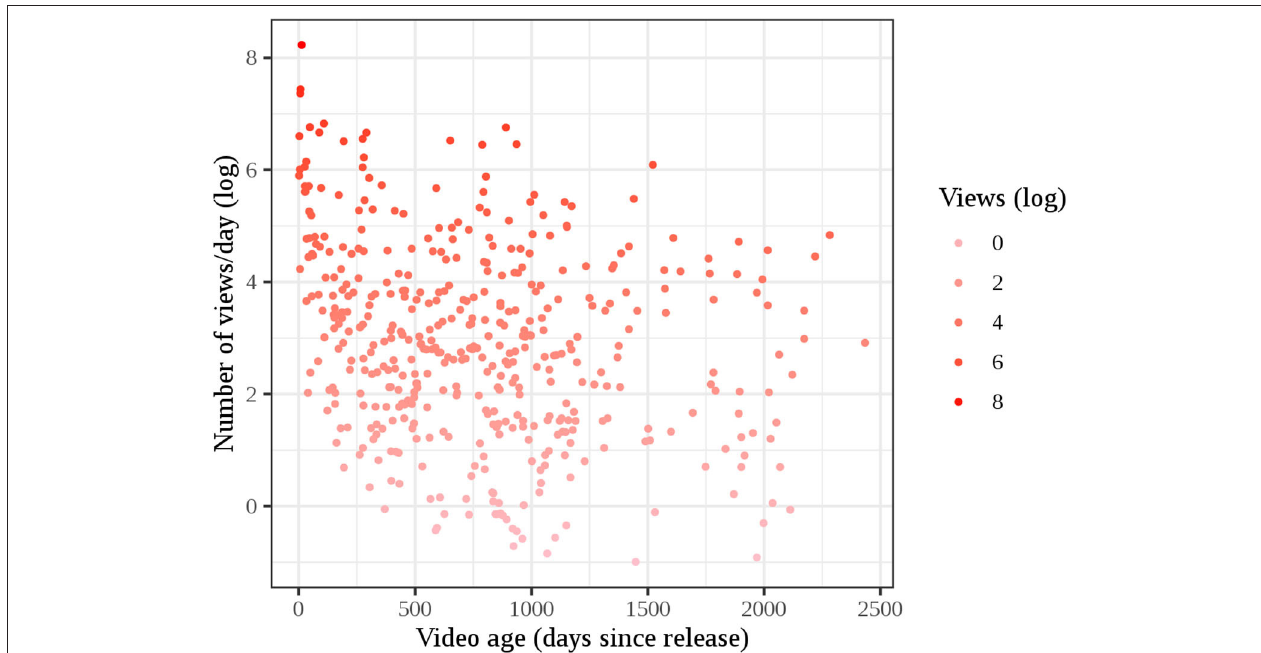
FIGURE 7 | Number of views per day (log) x video age (days).